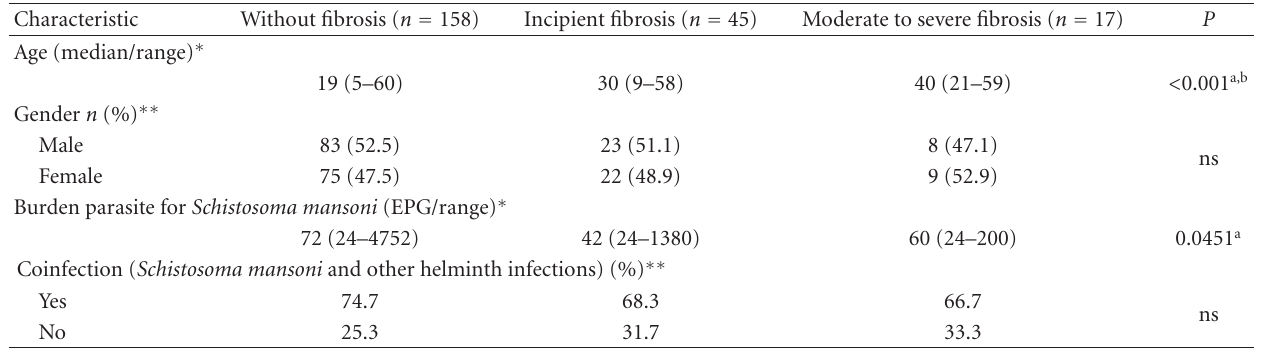
Table 1: Demographic characteristics of the individuals enrolled in the study ( n =